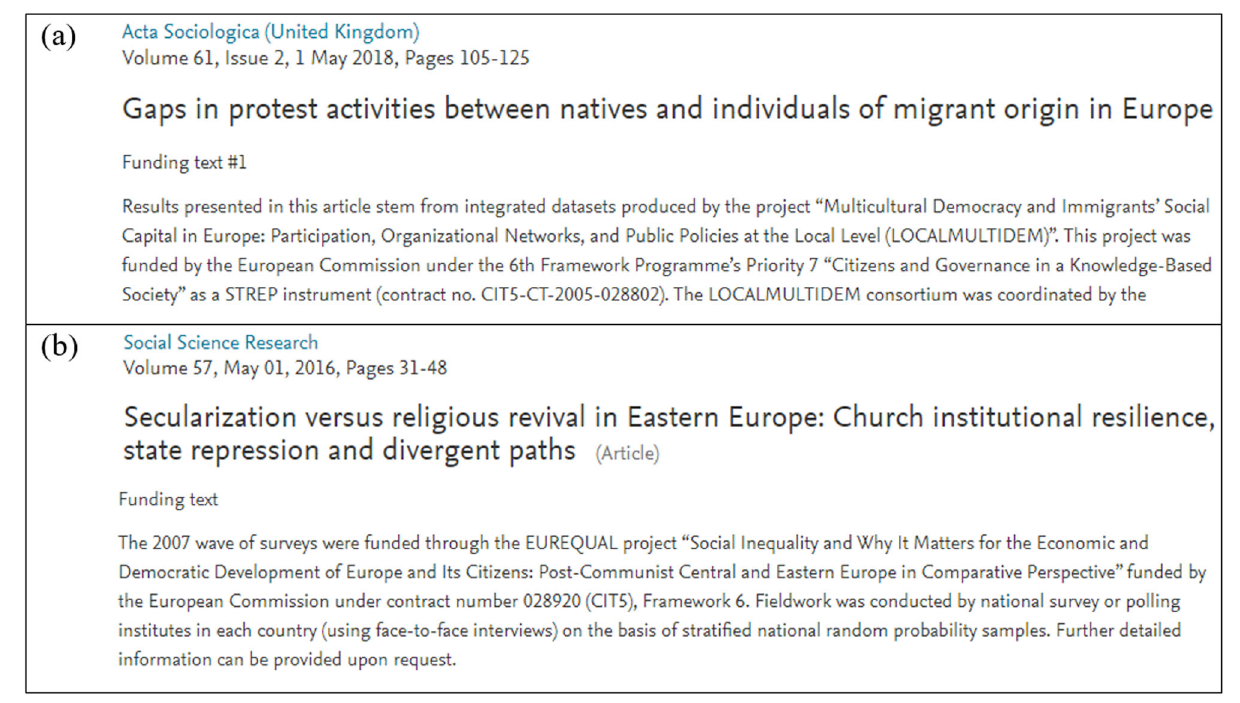
Fig. 8 Examples of bibliographic record in Scopus of articles with acknowledging the use of datasets gathered in the course of an old FP6 project. a Bibliographic record in Scopus of an article published in 2018 acknowledging the use of datasets gathered in the course of a FP6 project. b Bibliographic record in Scopus of an article published in 2019 acknowledging the use of the results of a survey conducted in the framework of a FP6 project.